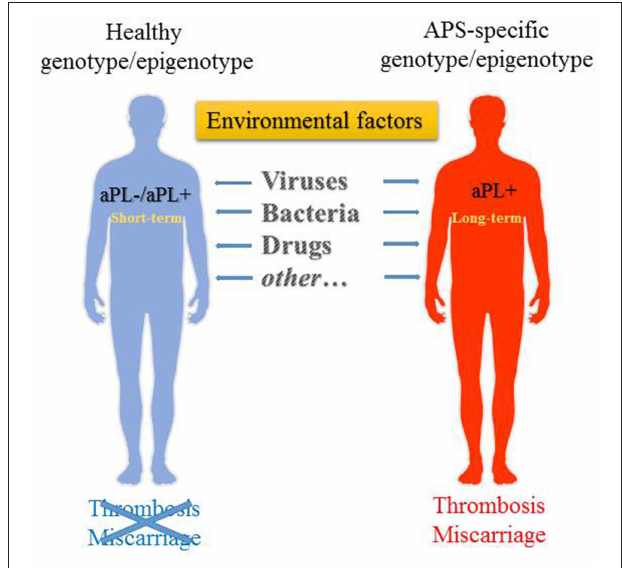
FIGURE 1 | Environmental factors that may trigger the generation of aPL. aPL generation can be triggered in both genetically susceptible as well as non-susceptible individuals, albeit it is transient in the latter. Long-term persistence of aPL in predisposed individuals may then lead to the development of